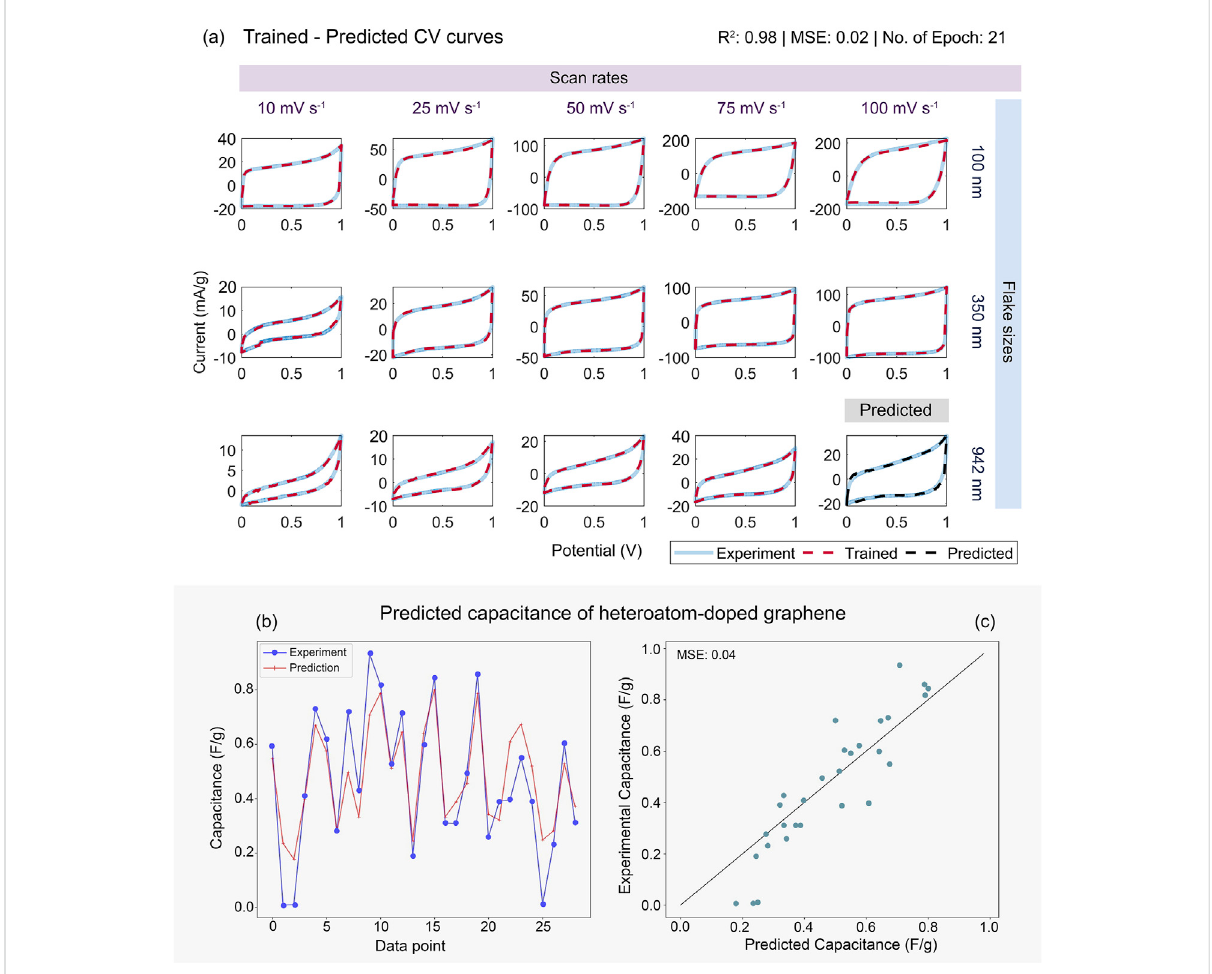
FIGURE 2 (A) Trained and Predicted CVs plotted in comparison with experimental CVs of different graphene fl ake sizes and scan rates. (B) The predicted capacitanceofheteroatom-dopedgrapheneplottedwithexperimentaldata. (C) Linearregressionplotofpredictedcapacitance versus experimental